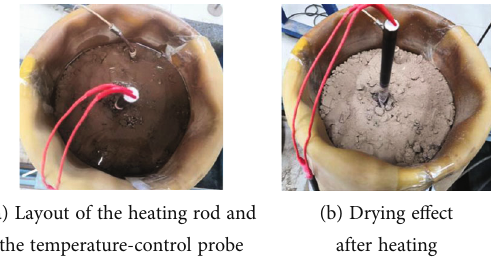
Figure 5: Sample drying. Table 1: Triaxial test scheme of the coarse-grained soil under drying – wetting cycles. N denotes the natural state, S denotes the saturation state, and DW2 – 7 denote the second to seventh drying – wetting cycles.